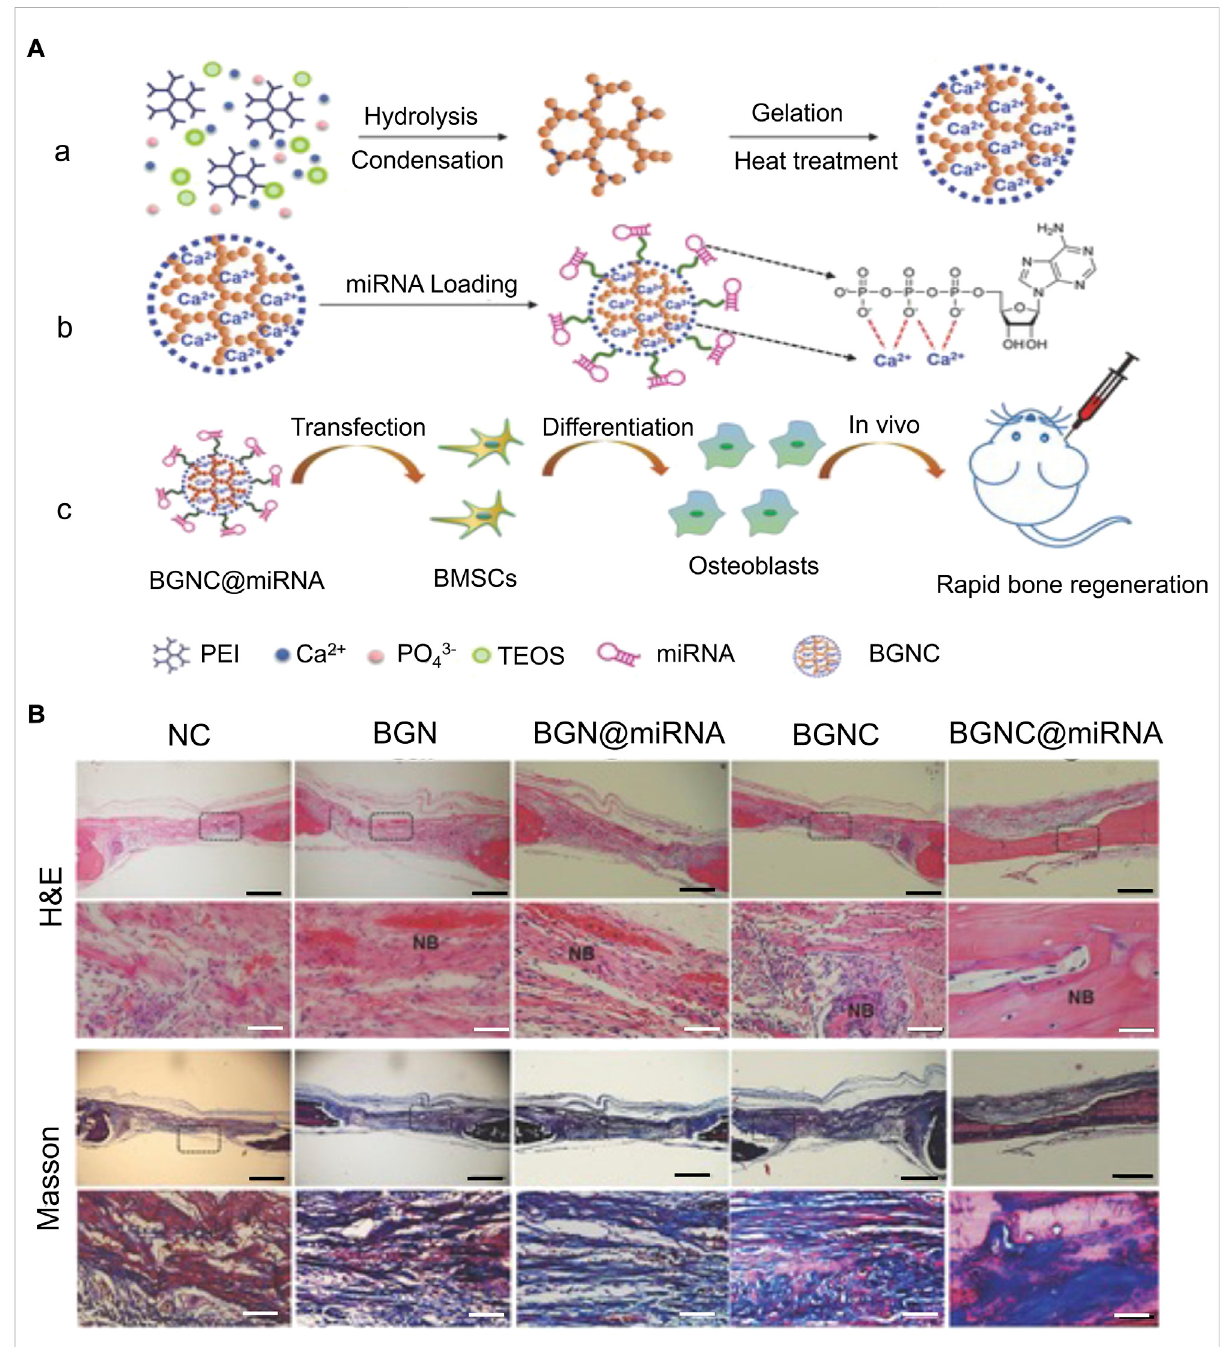
FIGURE 7 Monodispersed Bioactive Glass Nanoclusters (BGNCs) as vectors of miRNA promote osteogenic regeneration (Xue et al., 2017). (A) Schematic diagram of BGNC manufacturing and miRNA delivery applications. (a) Branched PEI-assisted synthesis of BGNCs. (b) miRNA loading. (c) miRNA deliveryregulatestheosteogenicactivityofstemcells invitro andboneregeneration invivo . (B) BonetissuesamplesweretakenforH&Estainingand MTC staining after 4 weeks of implantation in the rat parietal bones ’ defect, with the black line representing 1 mm and the white line representing 100 µm. (NC, using the pure fi brin glue hydrogel as negative control; BGN, bioactive glass nanoparticle; BGN@miRNA, BGN with miRNA; BGNC@miRNA, BGNC with miRNA; TEOS, tetraethyl orthosilicate.) Copyright 2017 WILEY-VCH Verlag GmbH & Co. KGaA, Weinheim. Reproduced with permission from John Wiley and